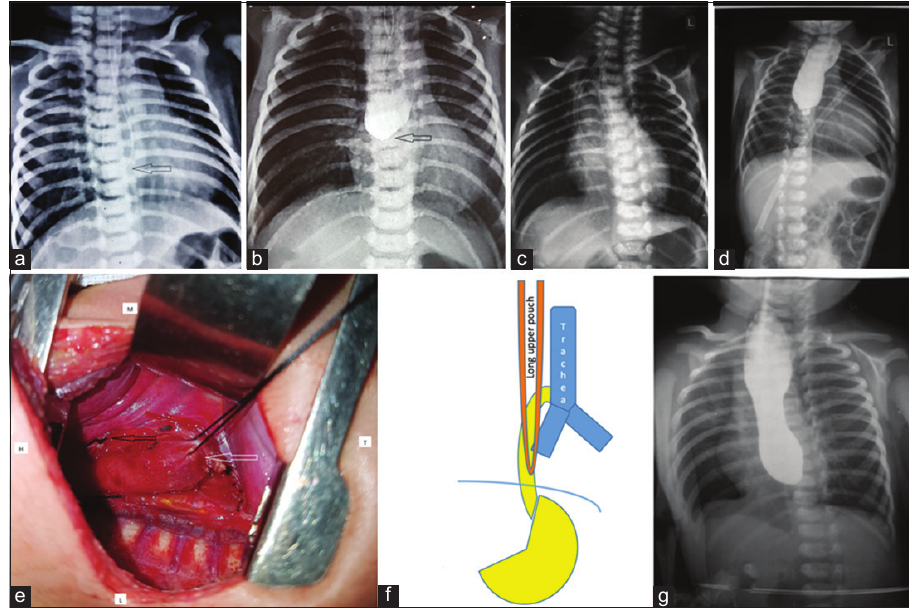
Figure 1: Composite figure of the three cases (a and c) showing the orogastric tube reaching well below T4 level. (b, d, g) Showing the upper pouch on a dye study. Note the pouch is wide and well developed, reaching up to diaphragm. (e) Upper pouch as seen intraoperatively. (f) Schematic diagram showing the anatomical with esophagobronchoscopy. The esophagobron- choscopy will show the fistula and the blind-ending esophageal pouch and establish the diagnosis. This thoracotomy.